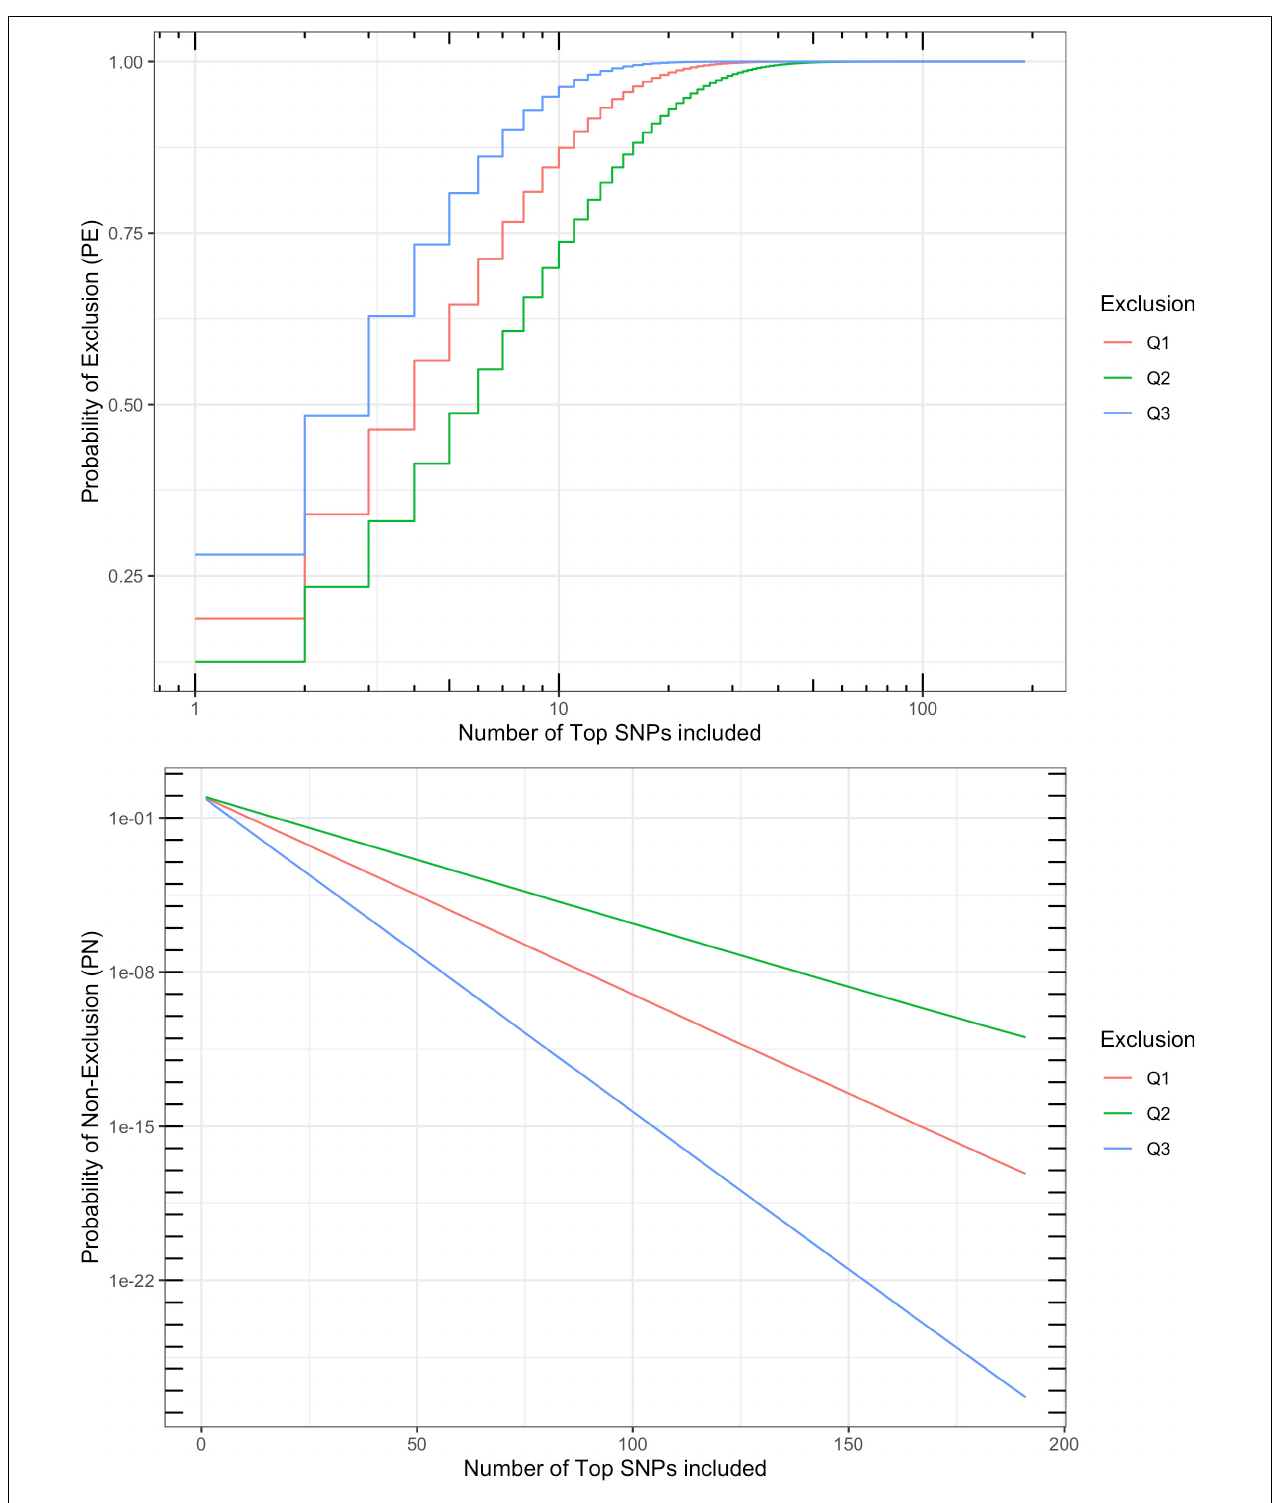
FIGURE 5 | Probability of exclusion (PE) and probability of non-exclusion (PN) for different numbers of top parentage SNPs. Multi-locus PE is the probability to exclude (1) a random unrelated parent when the other parent is known (Q1), (2) a random unrelated parent when the other parent is unknown (Q2), or (3) a random unrelated offspring